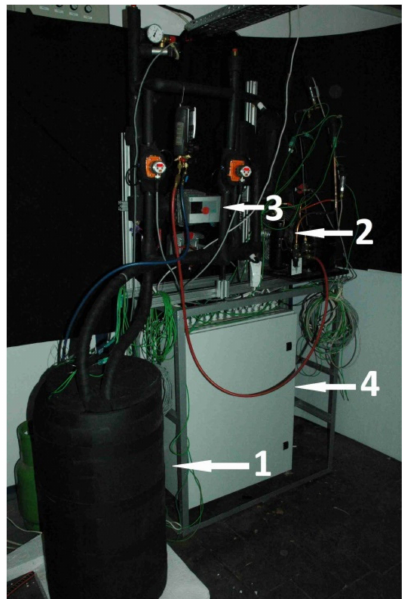
Figure 10. Photo of the experimental stand: 1 —LHTES, 2 —compressor chiller, 3 —circulating pump, 4 —control and measurement